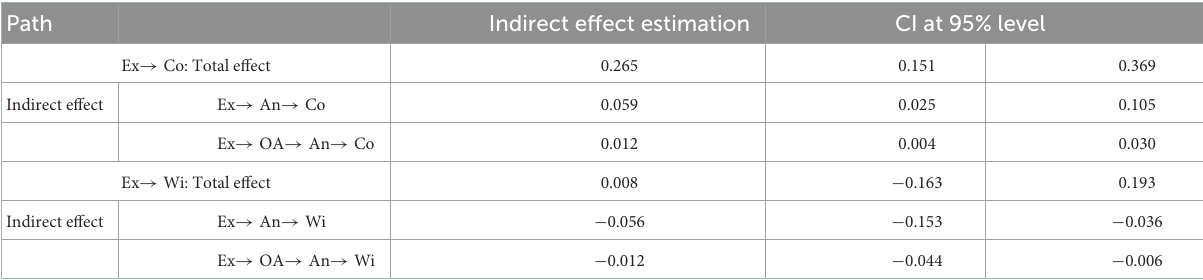
TABLE 3 Mediating effect and 95% confidence interval estimated by the Bootstrap method.